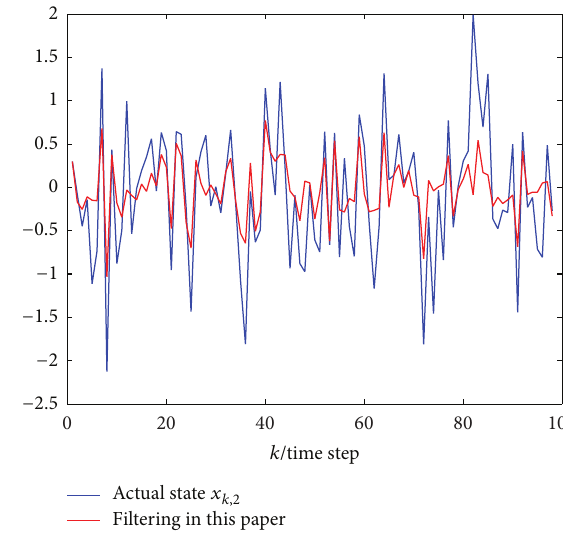
Figure 6: The trajectories of 𝑥 𝑘,2 and ̂𝑥 𝑘|𝑘,2 (Case II).